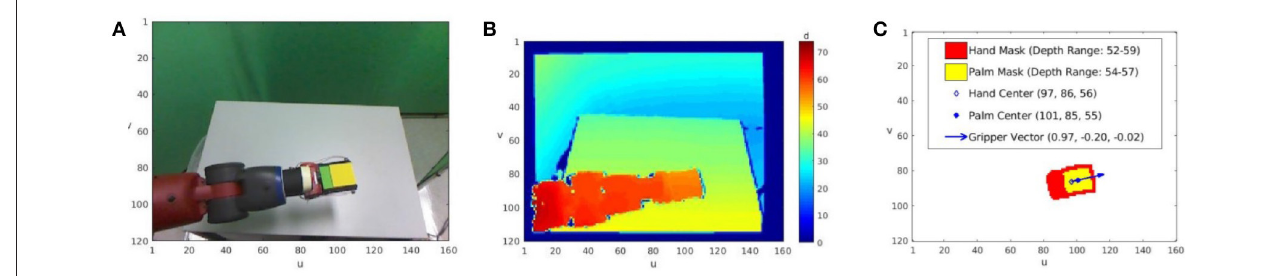
FIGURE 2 | An example of the agent’s visual percept and stored representation for a node n i . (A) A single RGB image I RGB , scaled down to 120 × 160 resolution, taken while the arm configuration is set to q i = q( n i ). (B) The registered depth image I D taken at the same time. Note that the depth values are a measure of disparity, so smaller values are further from the camera. (C) The full representation the agent stores for the node n i . Aided by the yellow block held between the gripper fingers, the agent segments the palm mask, corresponding to the grasping region of the hand. The larger hand mask includes the palm mask (shown in yellow) and parts of the robot image segment near the block, typically the gripper fingers and lower wrist (shown in red). The range of depth image values within each mask is also stored, as are the center of mass and mean depth value for each mask. Finally, to estimate the direction the grippers are pointing, a vector is drawn from the hand mask center through the palm mask